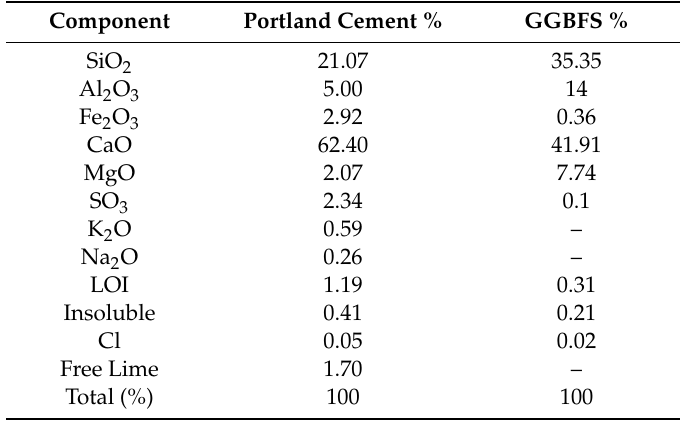
Table 2. Chemical analysis of materials. GGBFS, ground granulated blast furnace